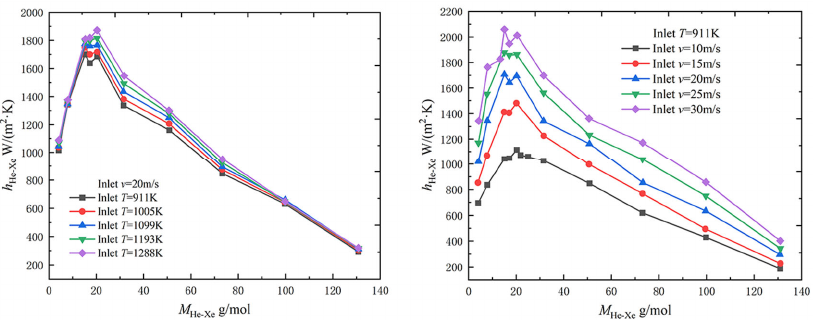
Figure 10. Effect of variation of inlet temperature and velocity on convective heat transfer coefficient of the helium–xenon gas mixture [9].